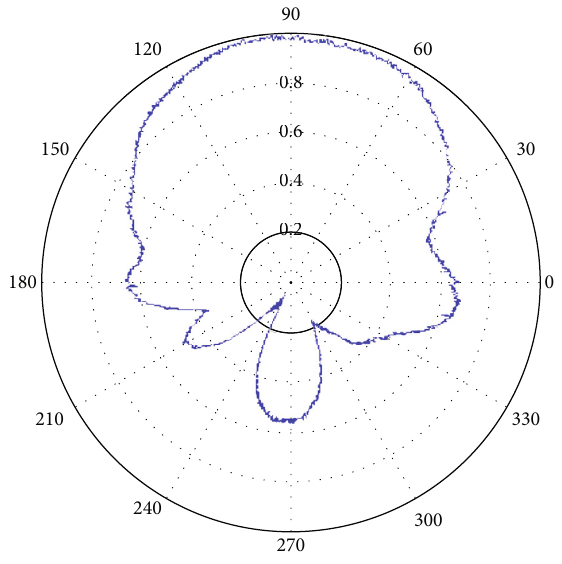
Figure 4: Measured radiation pattern of the Lucky-7 GPS antenna installed on the